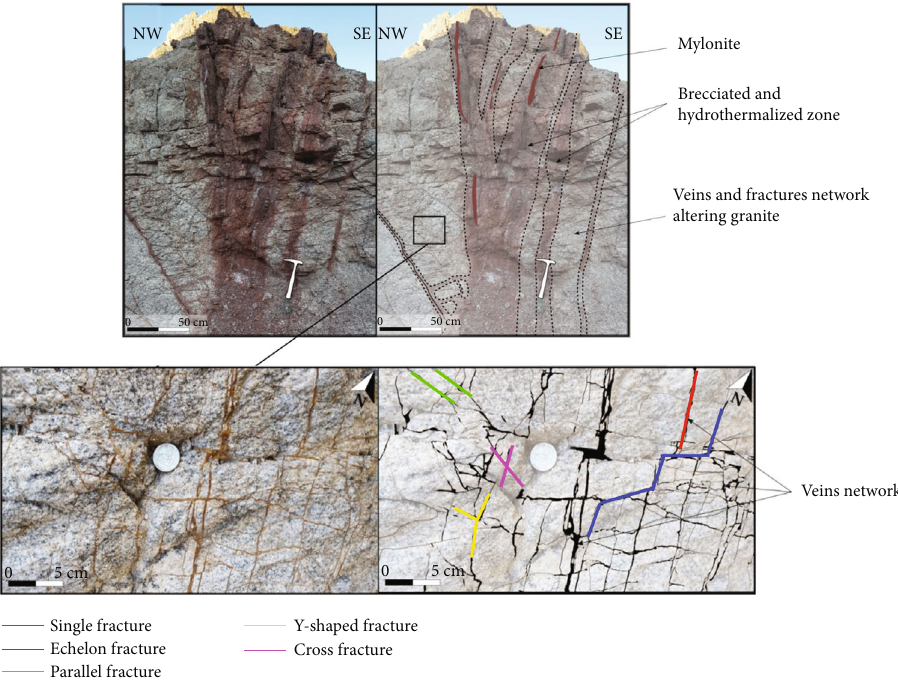
Figure 1: Diverse fracture patterns in granite outcrop (modi fi ed from Ref. [19]).